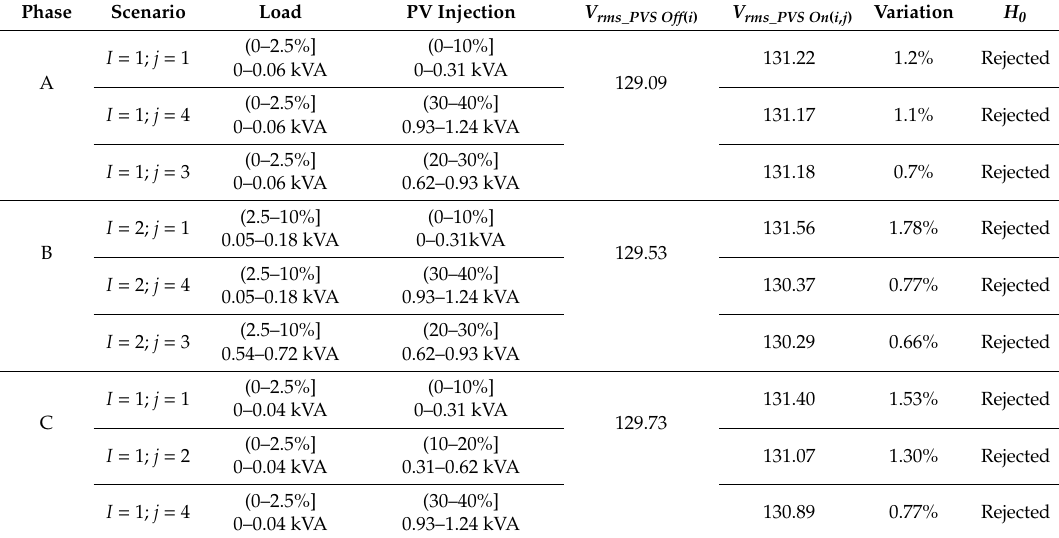
Table 5. Values of Vrms and results of the hypothesis testing for scenarios of greater probability for each phase.